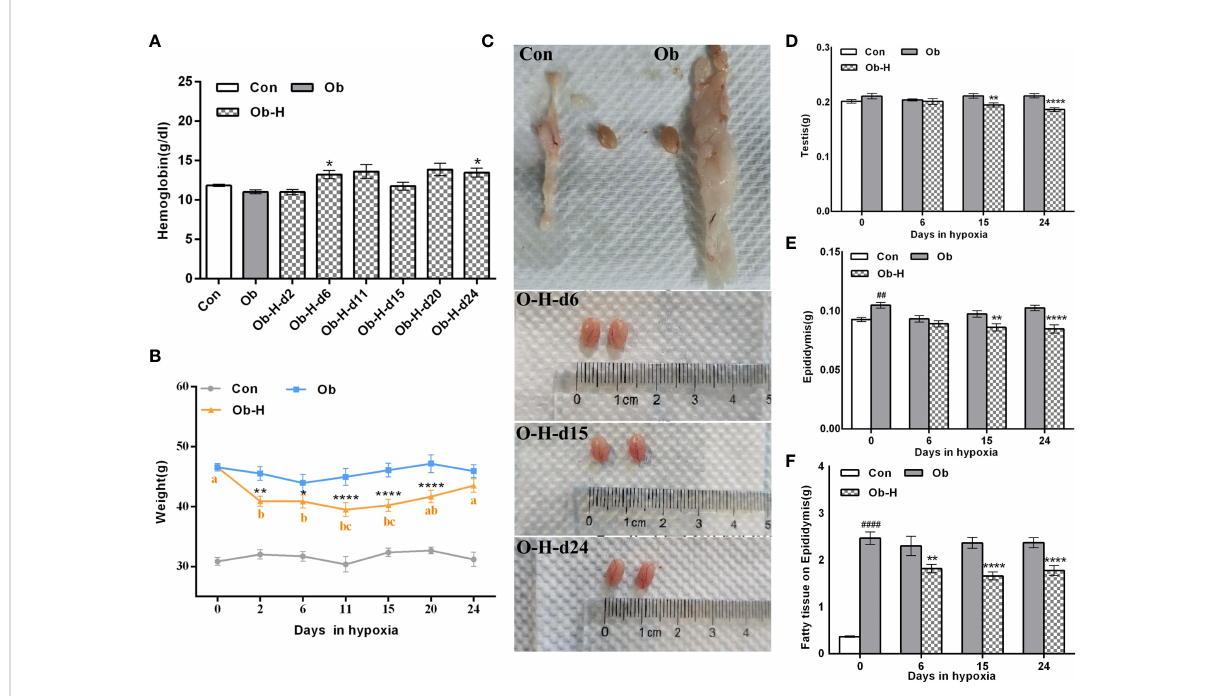
FIGURE 3 Impacts of chronic hypoxia exposure on HB, body weight, and organ weight in Ob mice. (A) Comparison of HB between the Ob and Ob-H groups. (B) Comparison of body weight between the Ob and Ob-H groups. (C) Comparison of testicular appearance between the Ob and Ob-H groups. (D, E) Comparison of the absolute weight of the testes and epididymides between the Ob and Ob-H groups. (F) Comparison of the absolute weight of the epididymal fat between the Ob and Ob-H groups. Data are represented as mean ± SEM. (A) n =10 – 19; (B) n = 6 – 19; (D – F) n = 16 – 22; ## P < 0.01 vs Con, #### P < 0.0001 vs Con; * P < 0.05 vs Ob, ** P < 0.01 vs Ob, **** P < 0.0001 vs Ob. Labeling with the same alphabetic letter represents an absence of differences between groups. Con, Control group; Ob, Obese group; Ob-H, Obese-Hypoxia